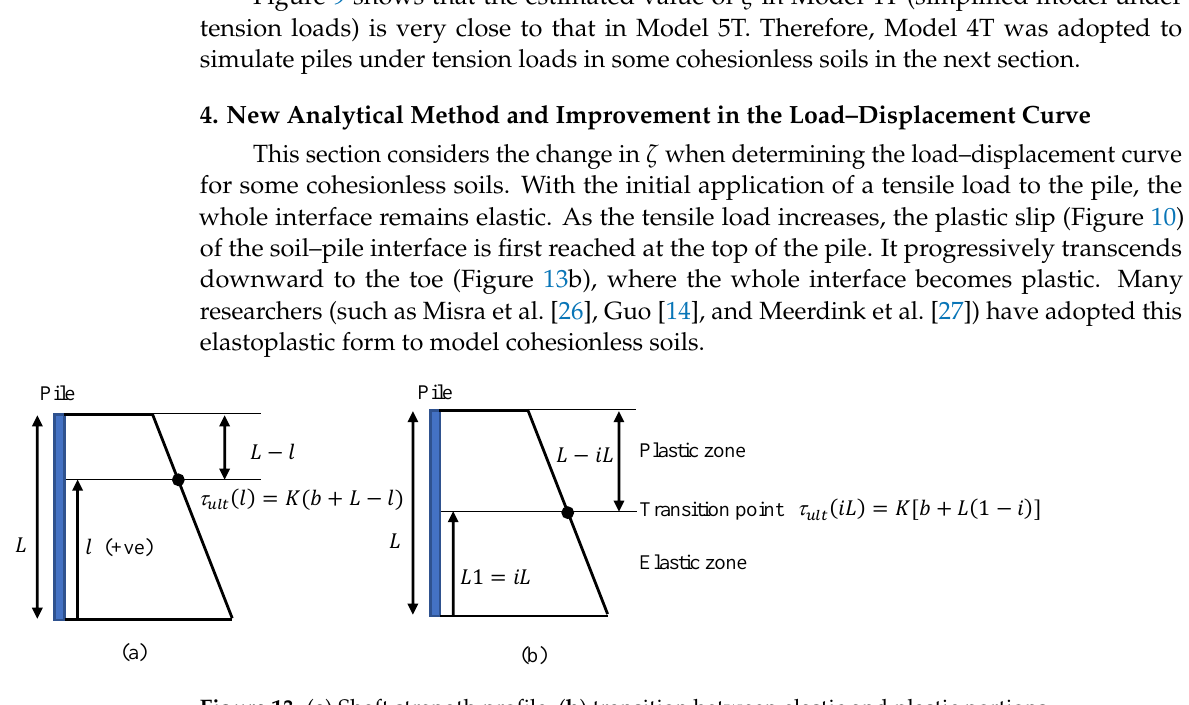
Figure 12. Slip ratio (slip depth to pile length) versus stress ratio at the mid-depth level of the pile.